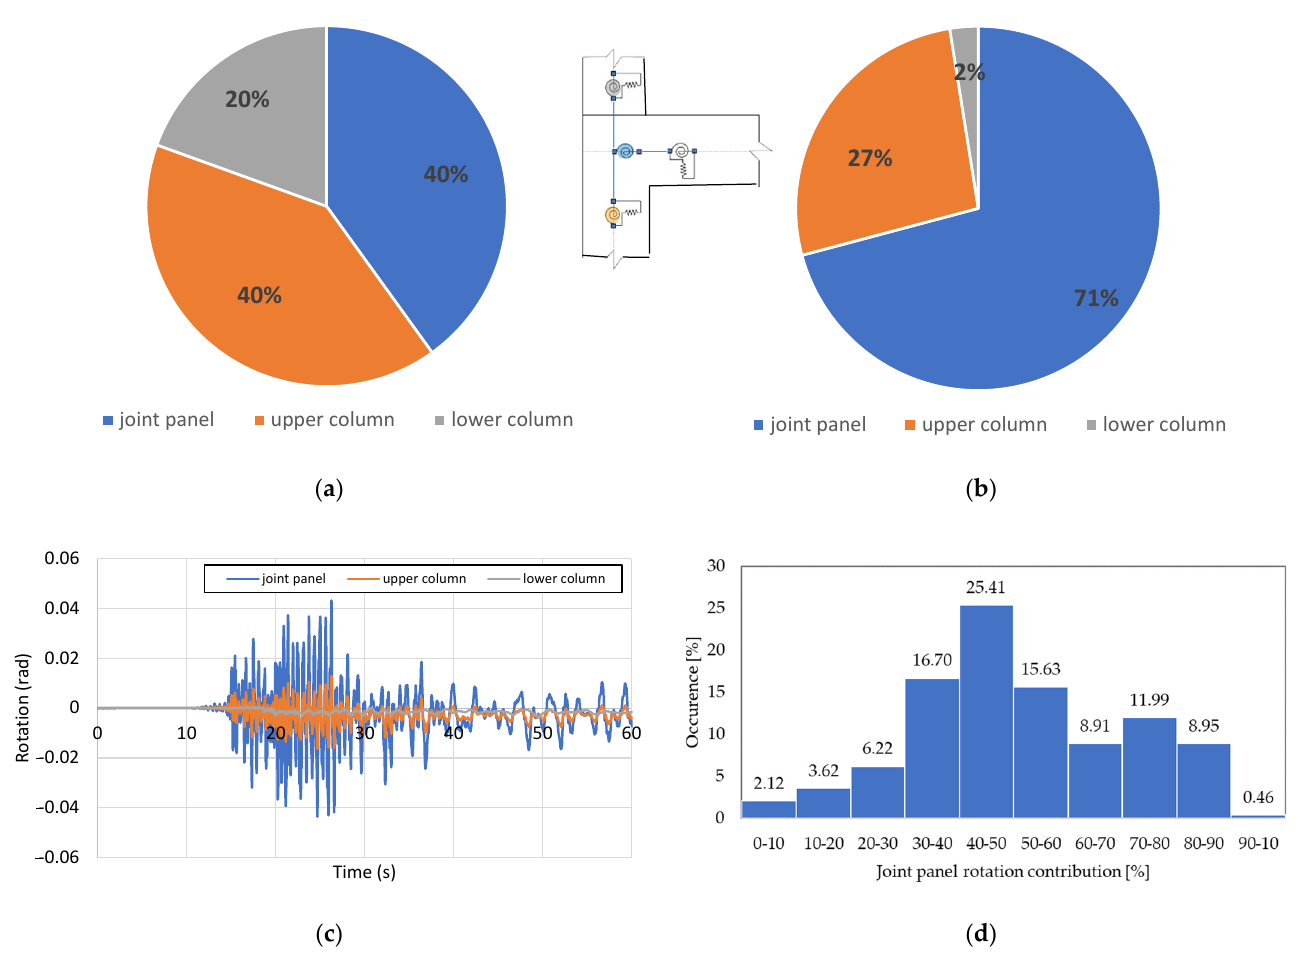
Figure 7. Deformability contribution of joint panel, upper column and lower column to the total rotation on an external node of the first floor during the first time-history analyses of the intensity level at 30% in 50 years HL. ( a ) Time-step corresponding to the attainment of the maximum interstorey drift ratio (instant 22.23 s of the time history); ( b ) Time-step corresponding to the attainment of the maximum rotation at the investigated joint panel (instant 27.35 s of the time history); ( c ) Example of rotation recorded for the joint panel, upper column and lower column; ( d ) Histograms diagram showing the distribution of the percentage values of the joint panel contribution during the time-history analyses.